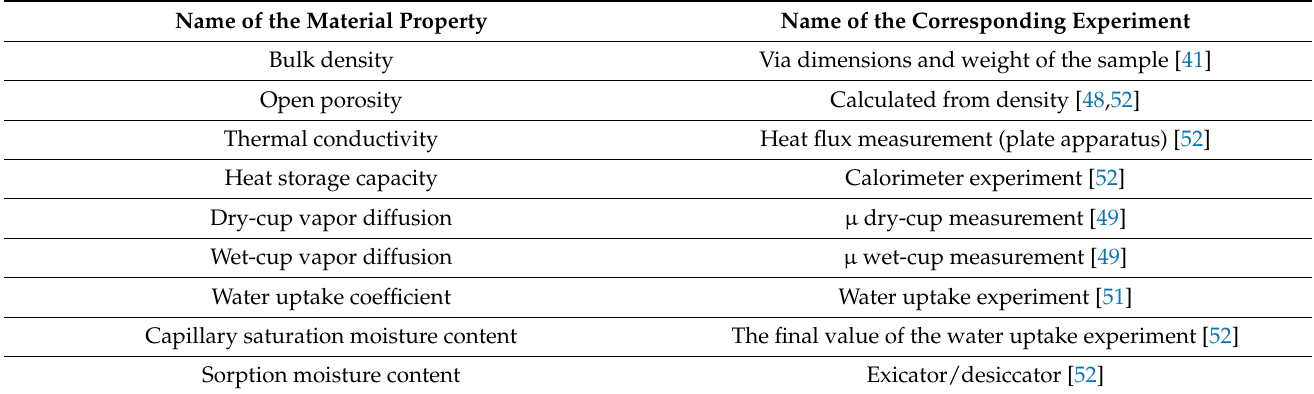
Table 5. Test methods for the properties of the dolomite stone.